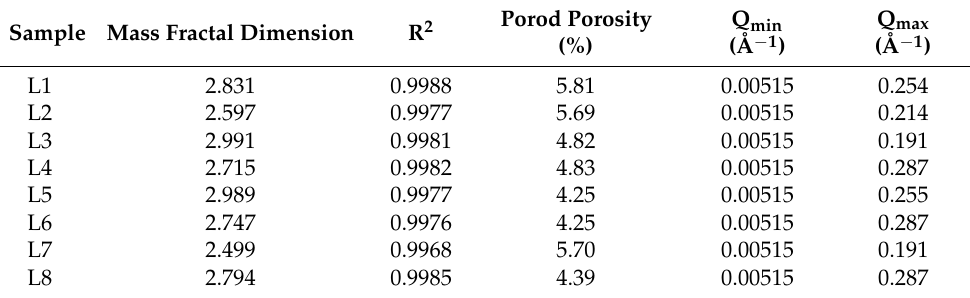
Table 2. SANS measurement of the physical parameters of deep shale.